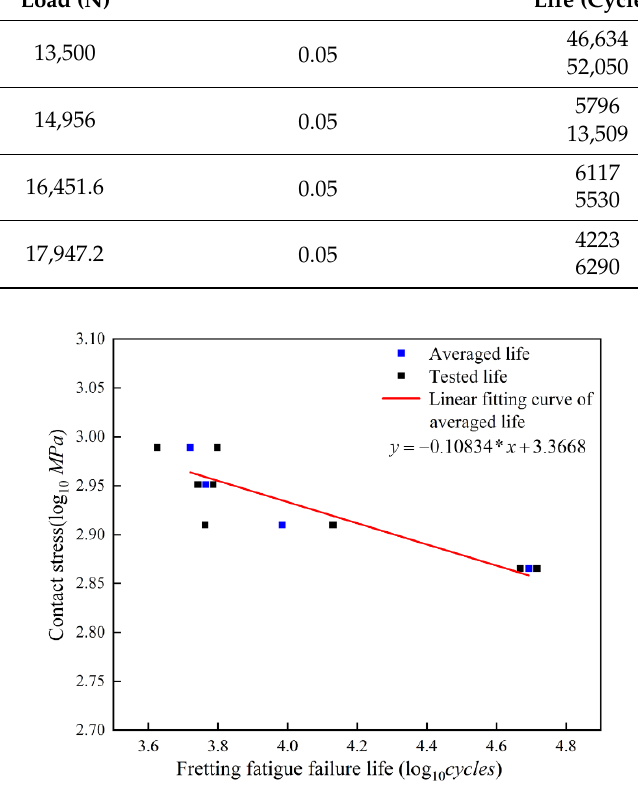
Figure 6. The fitting curve of maximum load and fretting failure life.